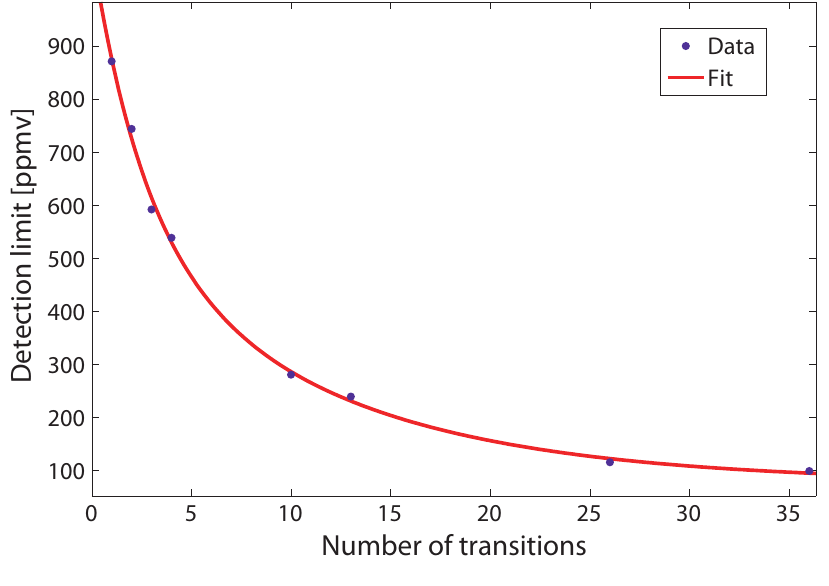
Figure 7. Detection limit of the system as a function of the number of transitions considered in Equation 9. The experimental values are shown as dots and the double exponential fit to the data as a solid red